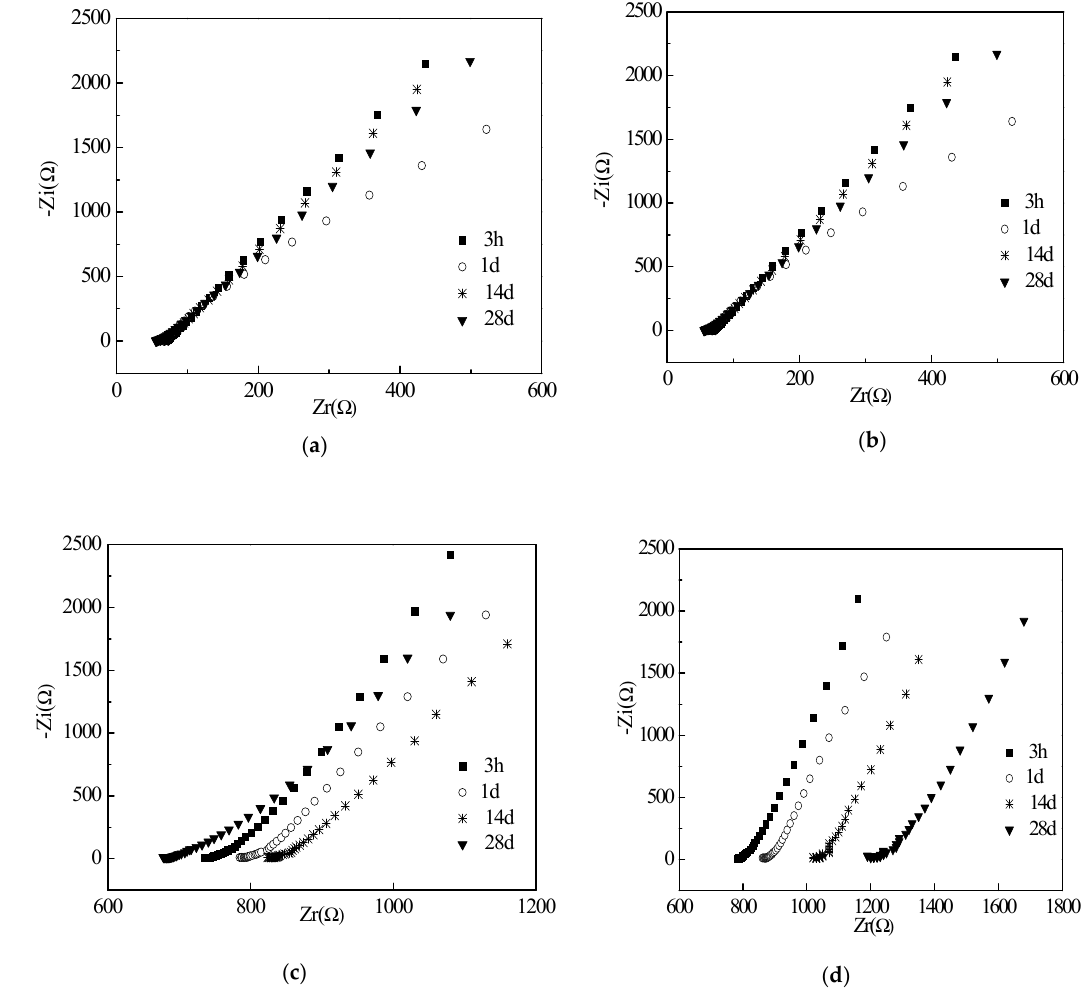
Figure 7. EIS curves of specimens with w/c ratio of 0.45: ( a ) RHA-5; ( b ) RHA-6; ( c ) RHA-7; ( d ) RHA-8.